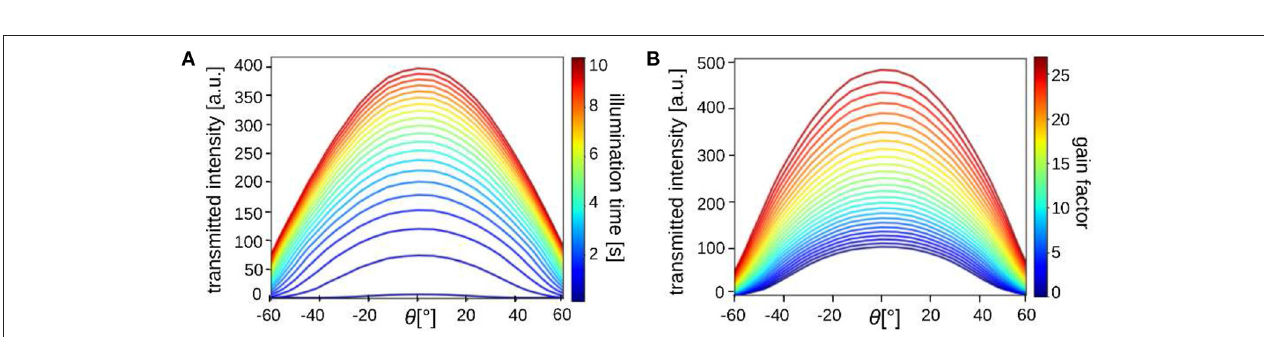
FIGURE 3 | Visualization of fiber orientations, shown exemplary for a region in Figure 5A : The in-plane fiber orientations are displayed by different colors (color wheel at the top left). Every image pixel contains 2 × 2 subpixels with up to four different colors, depending on the number of derived fiber orientations. Here, up to three different fiber orientations are shown (see enlarged region). Image pixels for which no fiber direction could be determined are displayed in black. Individual fiber orientations can be represented as colored lines (as shown on the right).